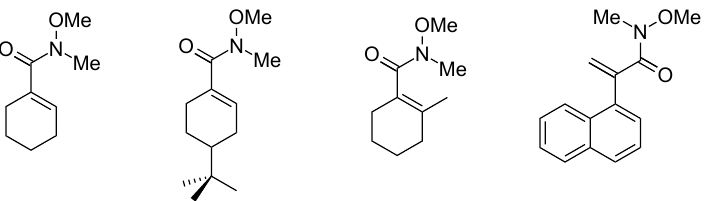
Figure 10. Weinreb amides from the aminocarbonylation of the corresponding iodoalkenes. 2-Iodobenzyl bromide was reacted with various N -nucleophiles and the resulting 2-iodobenzylamines were aminocarbonylated in the presence of Pd complexes. The in- tramolecular reaction proved to be highly chemoselective leading to 1-isoindolinone deriva- tives in high yields [53]. 5-Carboxamido-7-iodo-8-benzyloxyquinolines were synthesized in Pd-catalyzed aminocarbonylation of 5,7-diiodo-8-benzyloxyquinoline with high